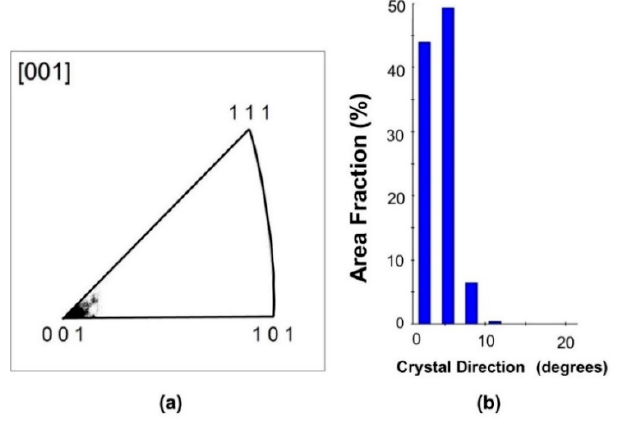
Figure 11. Distribution of surface direction around {100}. ( a ) IPF plot and ( b ) surface direction chart. 99.8% of the crystallized region is {100} ND-oriented within 10 ◦ . The SiO 2 cap thickness was 123 nm, and the power was 1.4 W. The scan velocity was 15 mm/s. After Sasaki et al. [52].